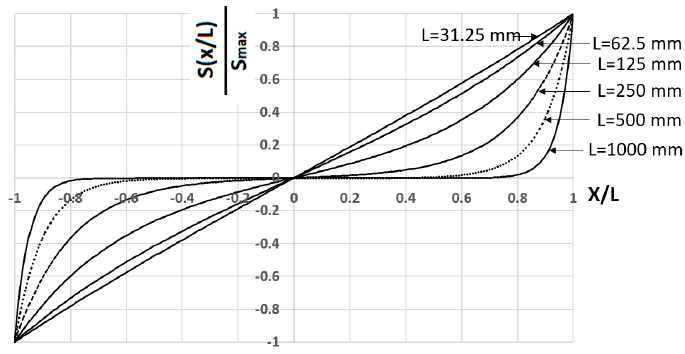
Figure 2. Variation of the slip along the